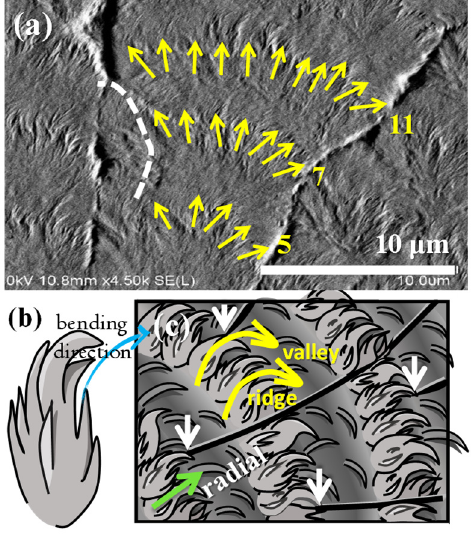
Figure 9. SEM micrograph of ( a ) top surface of banded-dendrites PPDO crystallized from PPDO/PVPh (75/25) blend at T c = 78 ◦ C, and ( b ) schematic for an individual fractal of crystal bundle in the ridge region, and ( c ) cycles of fractal-growth branches on the top surface of PPDO/PVPh (75/25).